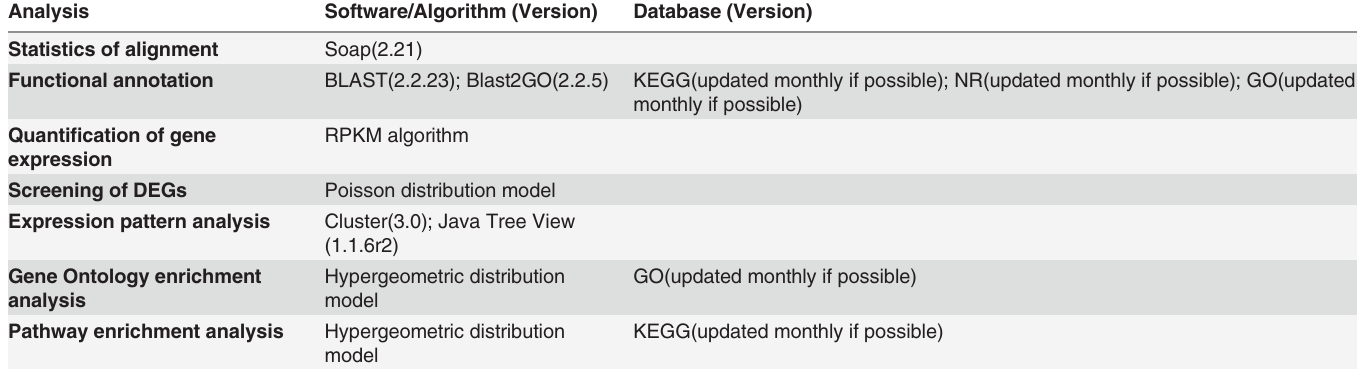
Table 1. Software and Databases.